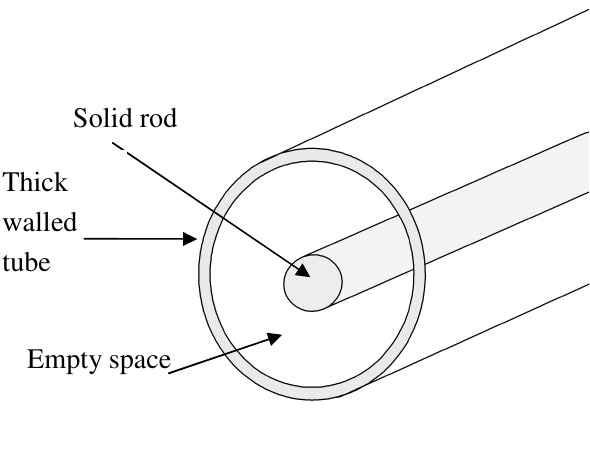
Figure 1. RHOF preform